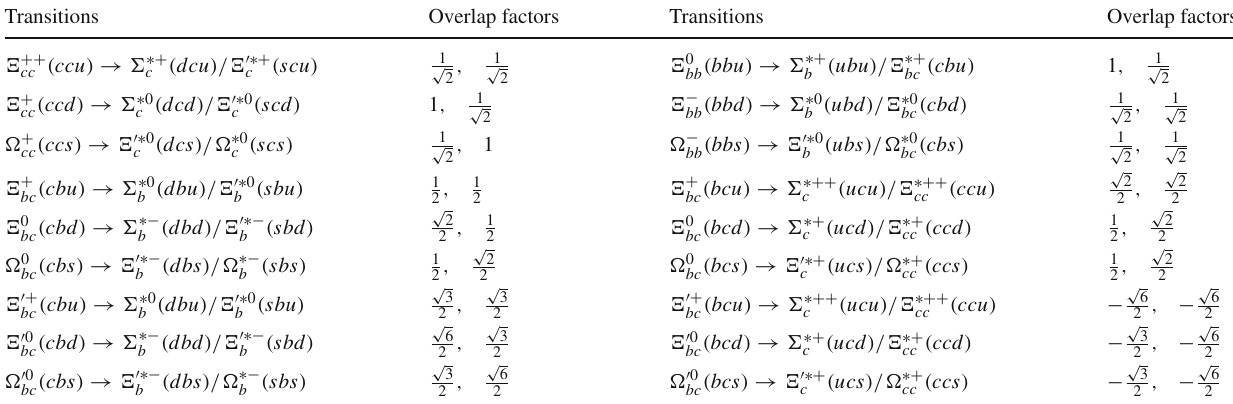
is defined with bc as a scalar or an axial-vector diquark bc